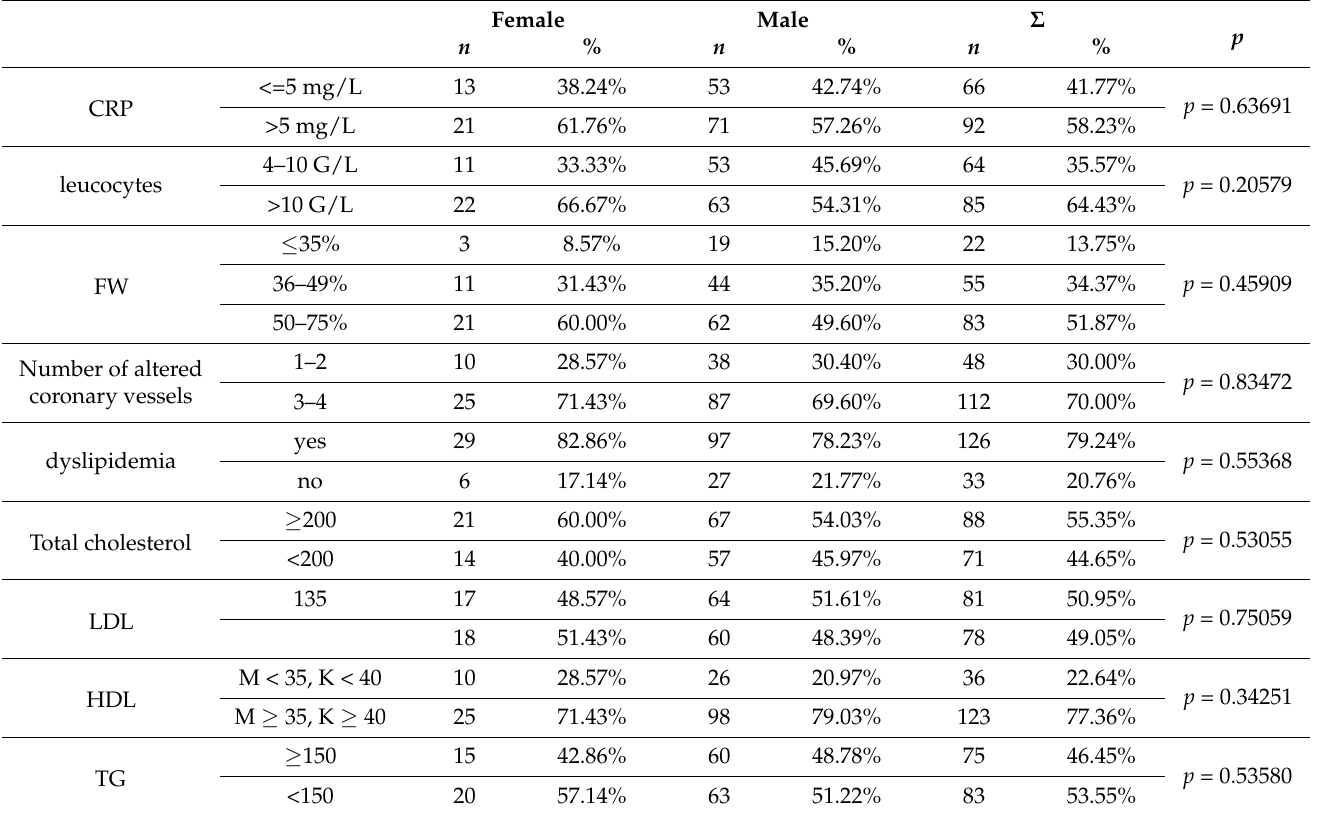
Table 7. Lipidogram, CRP, leukocytes, ejection fraction, number of coronary lesions by gender. Abbreviations: CRP, c-reactive protein; FW, ejection fraction; LDL; low-density lipoprotein; HDL, high-density lipoprotein; TG,